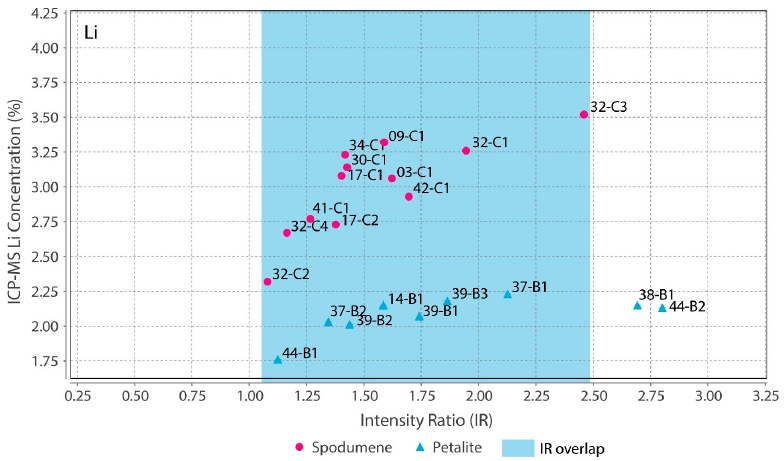
Figure 19. Overlap of the pLIBS Li intensity ratios for the spodumene and petalite samples of the Barroso–Alv ã o aplite-pegmatite